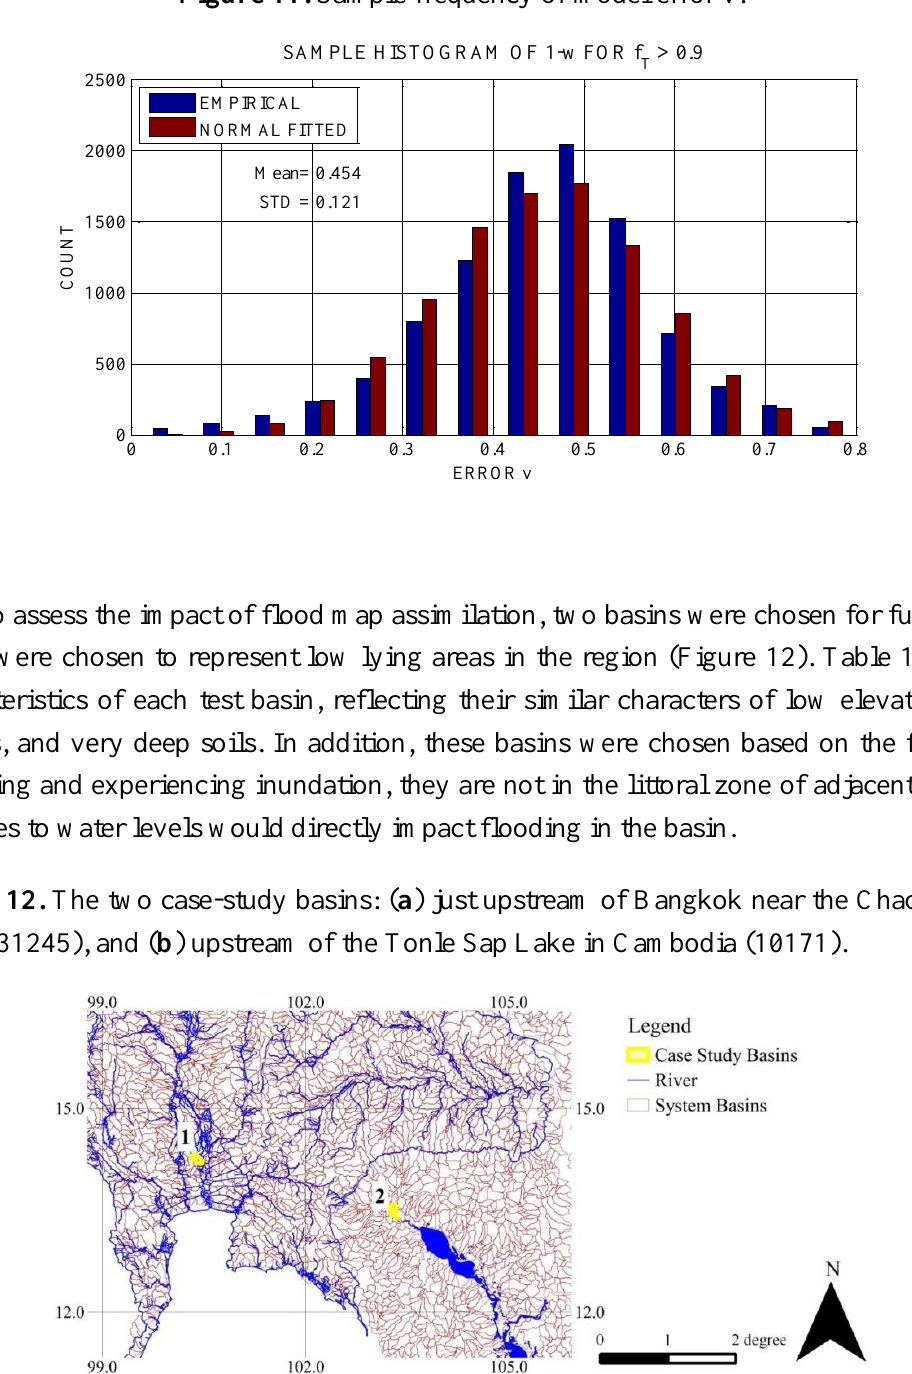
Figure 11. Sample frequency of model error v.